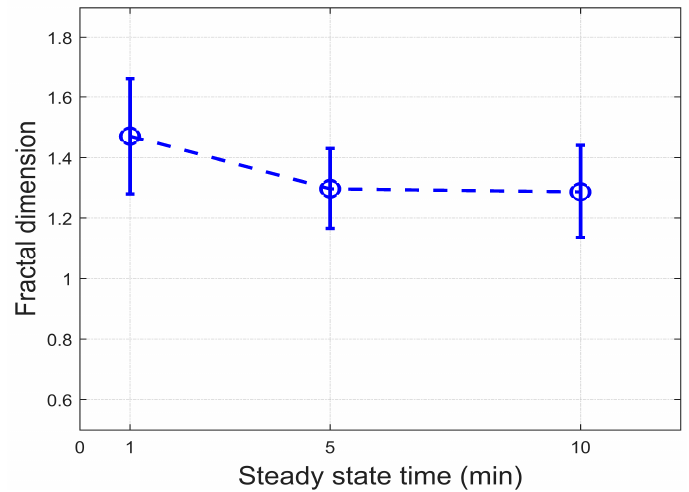
Figure 9. Fractal dimension as a function of steady state time.